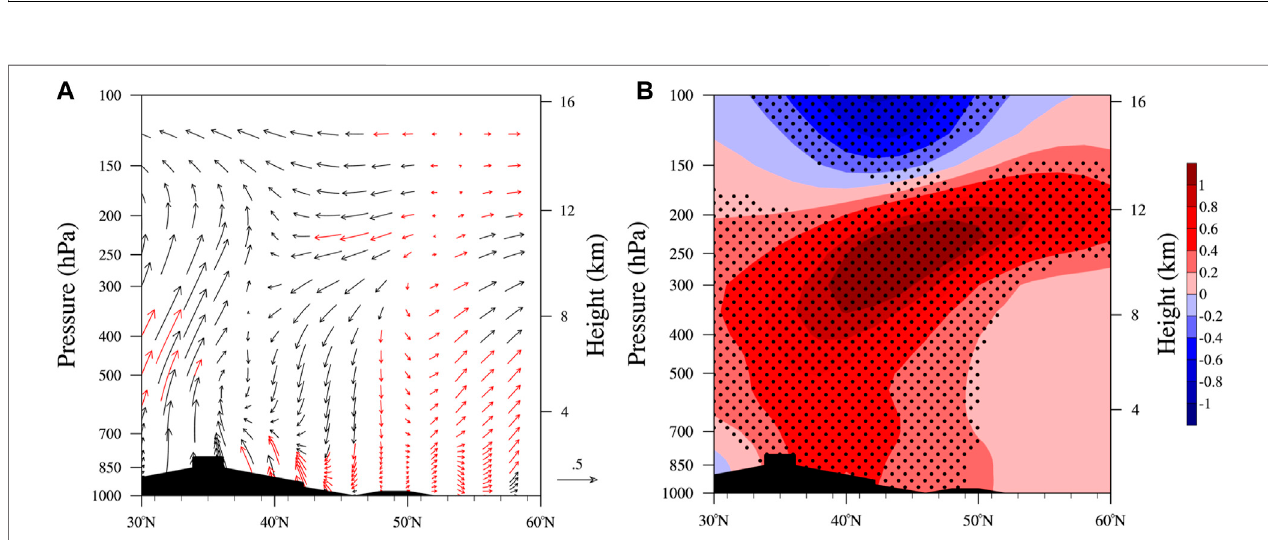
FIGURE12|(A,B) showtheregressioncoef fi cientsofMUTTIforazonalpro fi leaftertheradialaverageofthewind fi eldandtemperature,respectively.Theredwind fi eld in (A) and the dotted area in (B) show the area that passed the 90% con fi dence level student ’ s t-test.